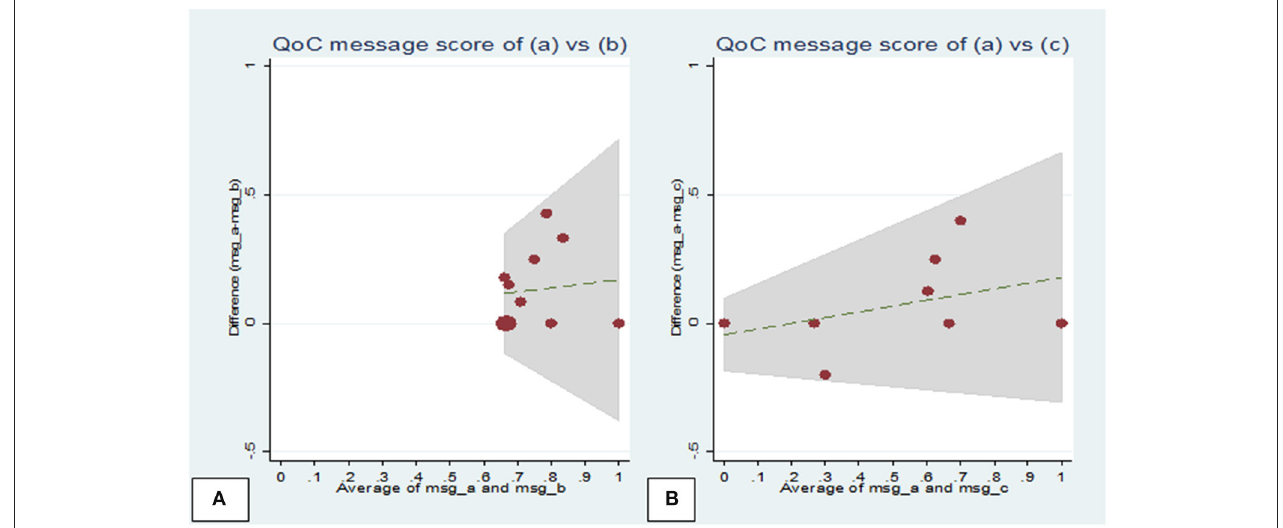
FIGURE 1 | Bland-Altman plots of the mean difference against the mean quality-of-care messages scores assigned by observers during household visits. (A) Plot showing observers (a) and (b) scores. Mean difference = 0.14, standard deviation (SD) = 0.20 (limits of agreement = mean − 2 × SD to mean + 2 × SD) = − 0.18 to 0.44; (B) Plot showing observers (a) and (c) scores. Mean difference = 0.07, SD = 0.18 (limits of agreement = mean − 2 × SD to mean + 2 × SD) = − 0.30 to 0.44. QoC, quality-of-care; msg, message.